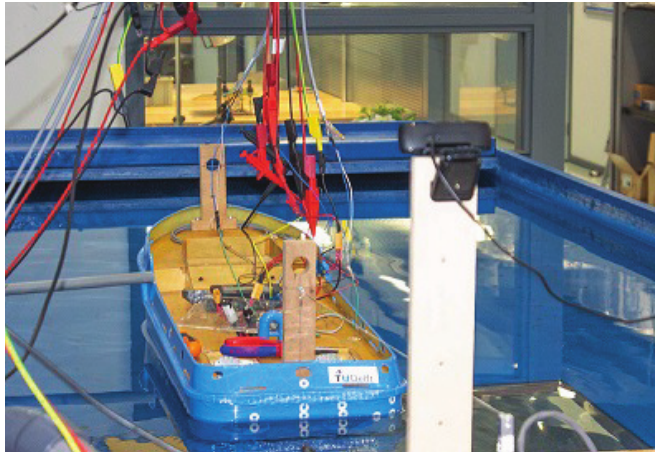
Figure 1. Tito Neri overview.